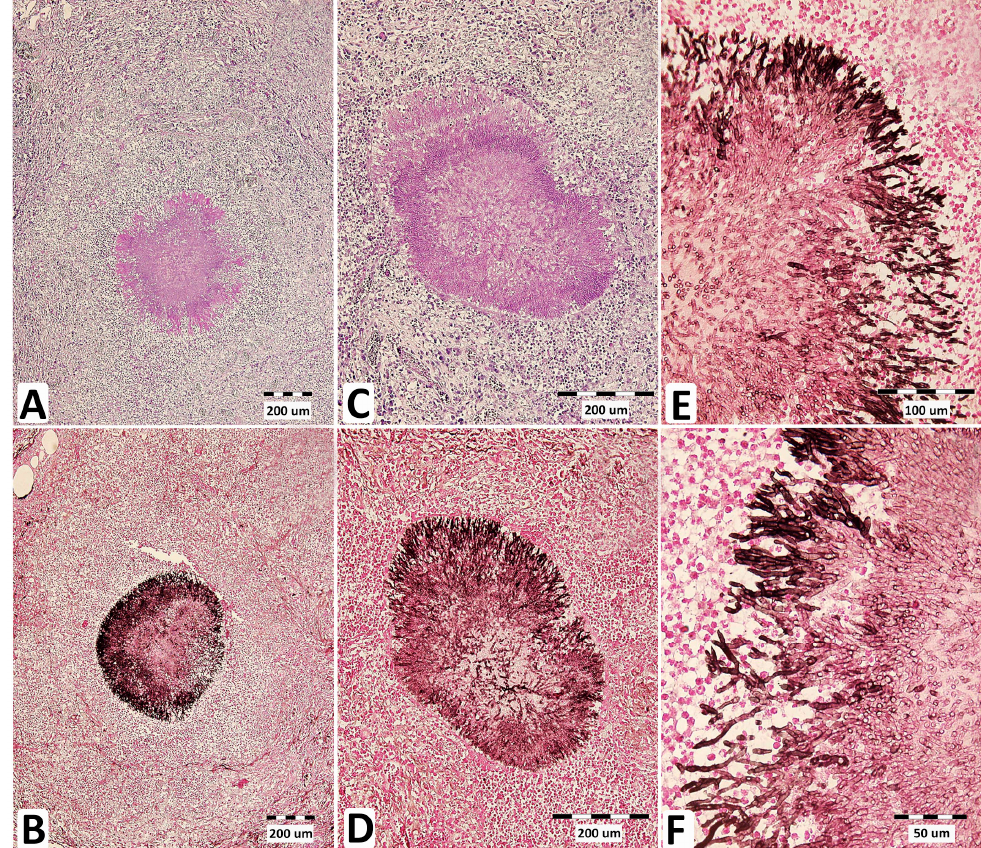
J. Fungi 2023 , 9 , x FOR PEER REVIEW 8 of 14 Figure 3. Micromorphology of A. fumigatus lung lesions in a stallion suffering from mycotic pneumonia. Central necrosis in pyogranuloma containing fungal elements visualized using periodic acid (Schiff stain) and Grocott’s methenamine silver (GMS) stain at 100 × magnification ( A , B ) and 200 × magnification ( C , D ), together with Aspergillus hyphae visualized by GMS staining at 600 × magnification ( E , F ).